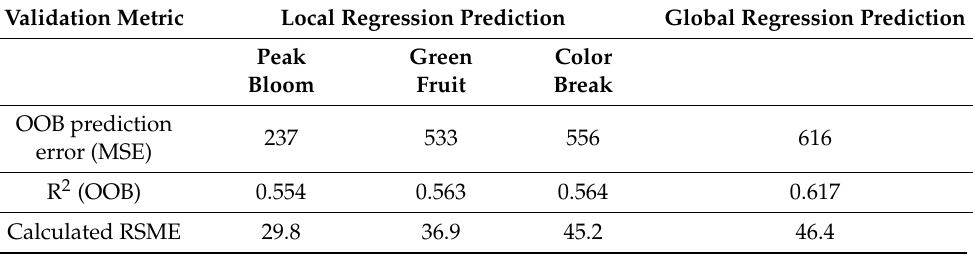
Table 2. Outline of global and local regression model statistics for predicting water